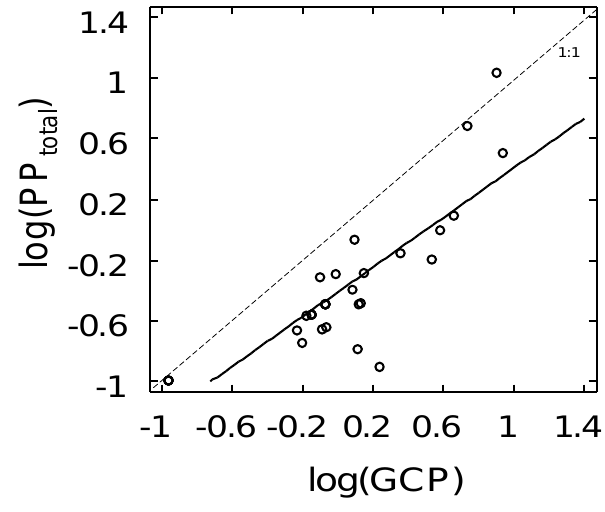
Fig. 4. Relationship between log-transformed total primary produc- tion (particulate and dissolved, PP total , mgCm − 3 h − 1 ) and gross primary production (GPP, mgCm − 3 d − 1 ) . The equation line is: log(PP total ) = 0 . 81 ( ± 0.09) · log(GPP) − 0.4 ( ± 0.04), r 2 = 0 . 72, p < 0 . 0001, standard error in parenthesis. GPP was converted to carbon units by applying a photosynthetic quotient (PQ) of 1.1 (Laws,